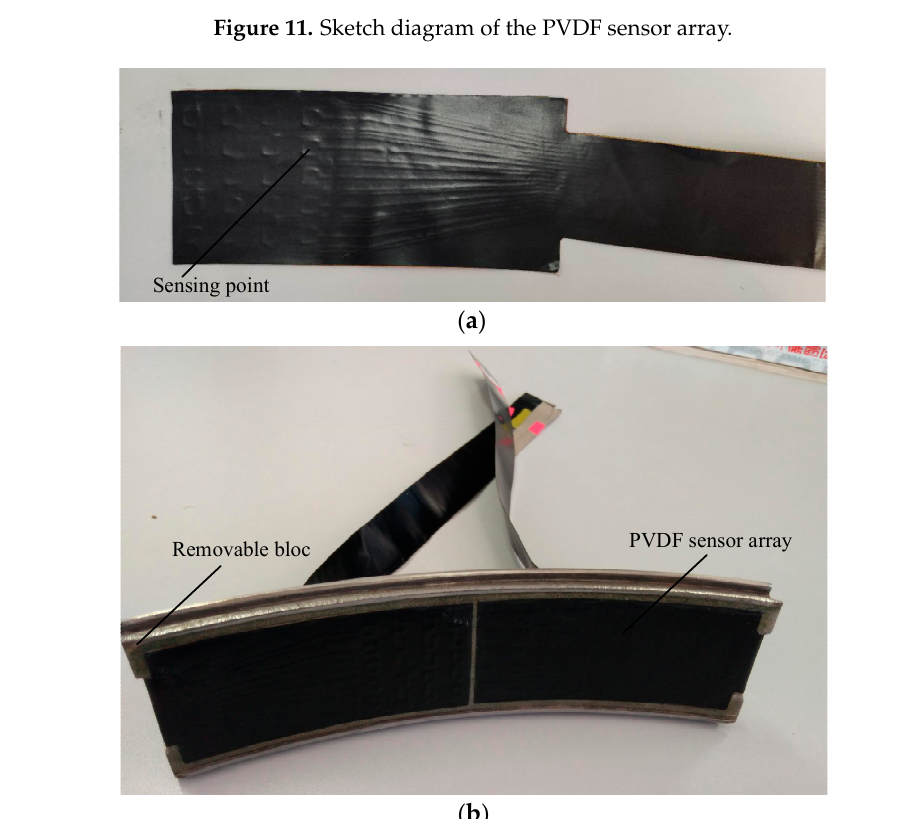
Figure 12. Photograph of the PVDF sensor array: ( a ) sensor photography, ( b ) installation photography.